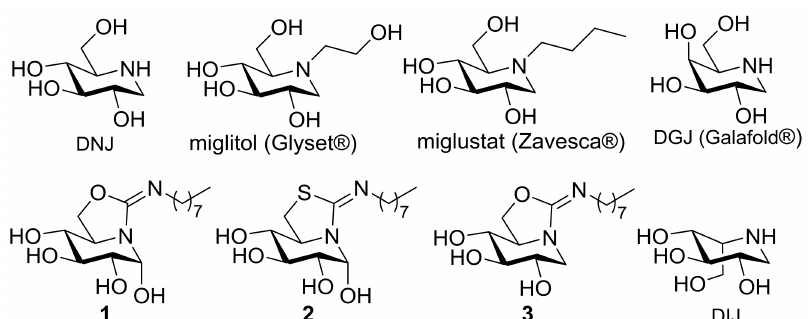
Figure 1. Structures of the iminosugars 1-deoxynojirimycin (DNJ), 1-deoxygalactonojirimycin (DGJ) and 1-deoxy- L -idonojirimycin (DIJ), the DNJ-related drugs miglitol and miglustat, and the sp 2 -iminosugars 1 – 3